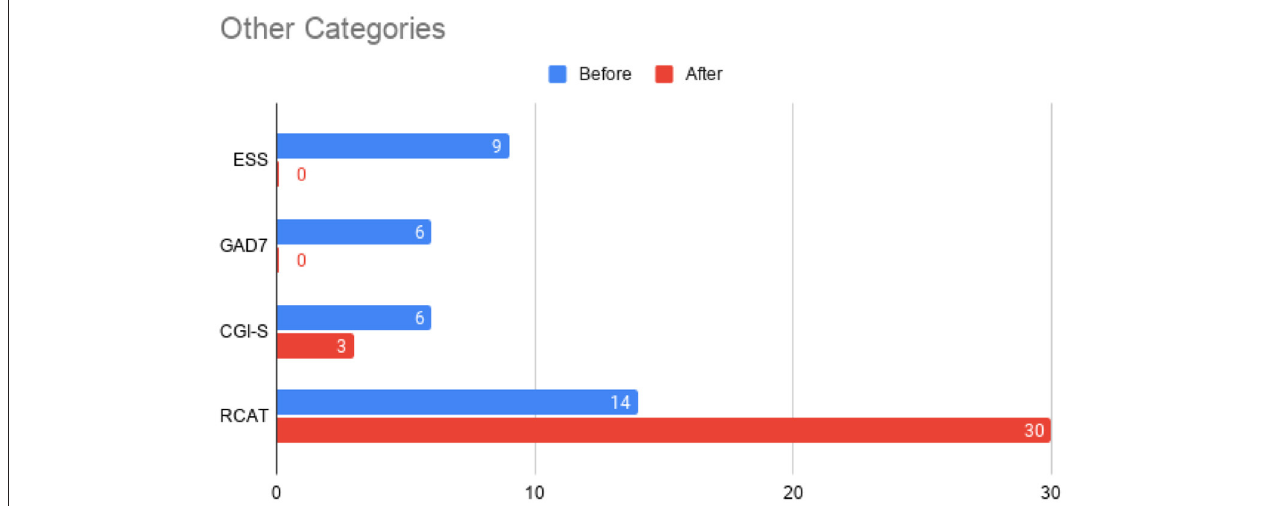
FIGURE 6 | Total scores before initiation of omalizumab (blue) and after the treatment period (red) for the Epworth Sleepiness Scale (ESS), General Anxiety Disorder 7-item (GAD-7) scale, Clinical Global Impressions – Severity (CGI-S) scale, and the Rhinitis Control Assessment Test (RCAT). In contrast to other parameters, RCAT scores indicate better improvement with higher scores, while the rest of the tests indicate better improvement with lower scores. The Clinical Global Impressions - Improvement (CGI-I) was rated a 2 at the conclusion of the treatment period, indicating “much improved”